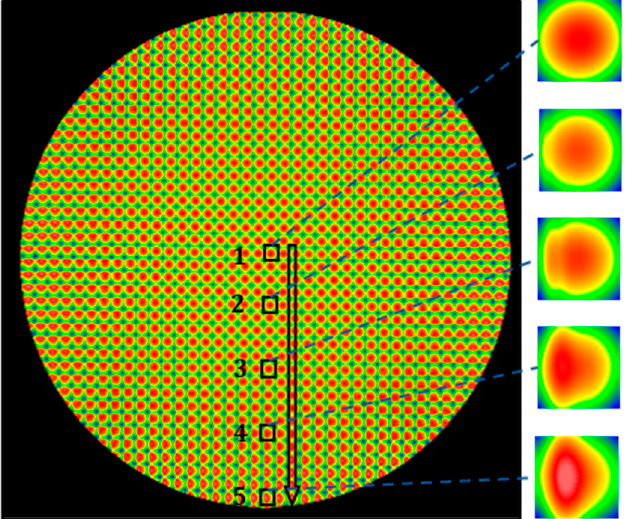
Figure 2. Lenslet array fabricated with the constant-angle strategy, with a constant-angle of 0.25 degrees and an inverse time feed of 0.001 s. The surface is measured and stitched together with a Zygo Newview 8300 optical surface profilometer. Five lenslets were selected for further analysis.